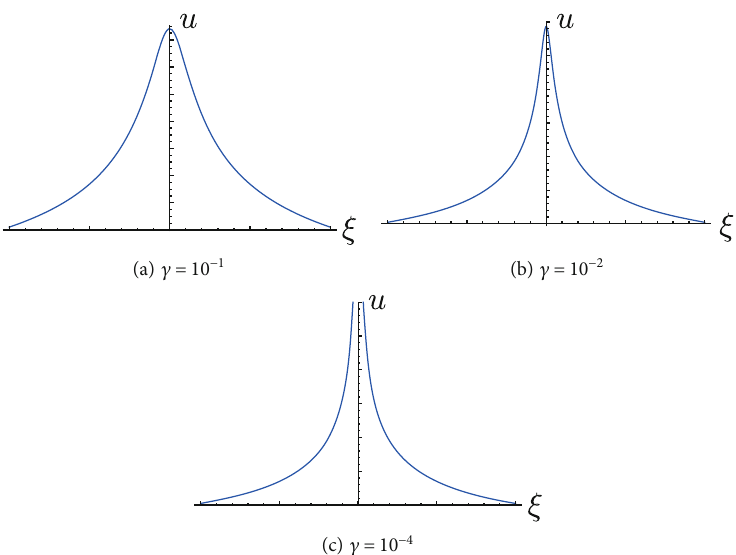
Figure 2: The varying fi gures of the example of u = u